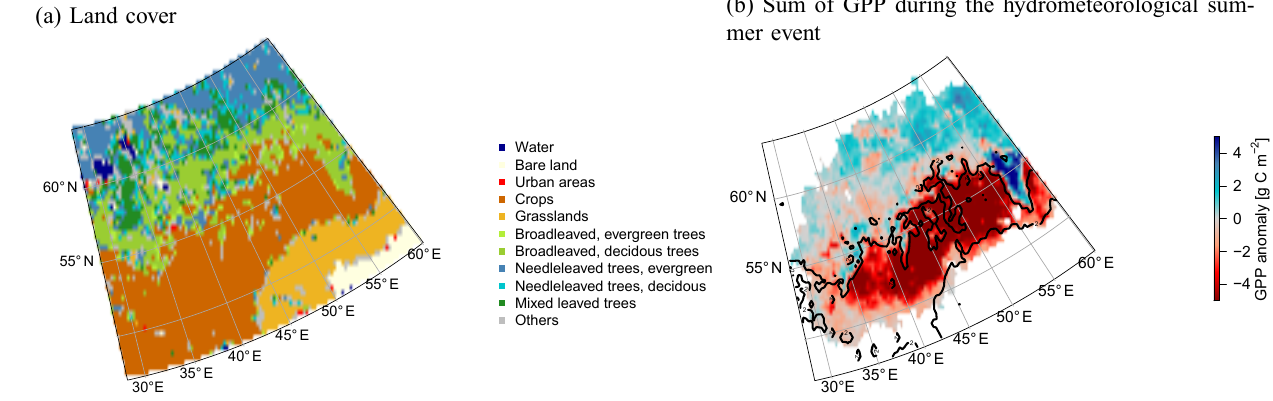
Figure 7. (a) Dominant land cover classes of a spatial extent of the RHW. (b) The boundaries of the different ecosystem types (forest- dominated ecosystems vs. agriculture-dominated ecosystems, denoted by the black contour line) match the observed patterns of the GPP response (reference period for the calculating anomalies: 2001–2011) during the hydrometeorological summer